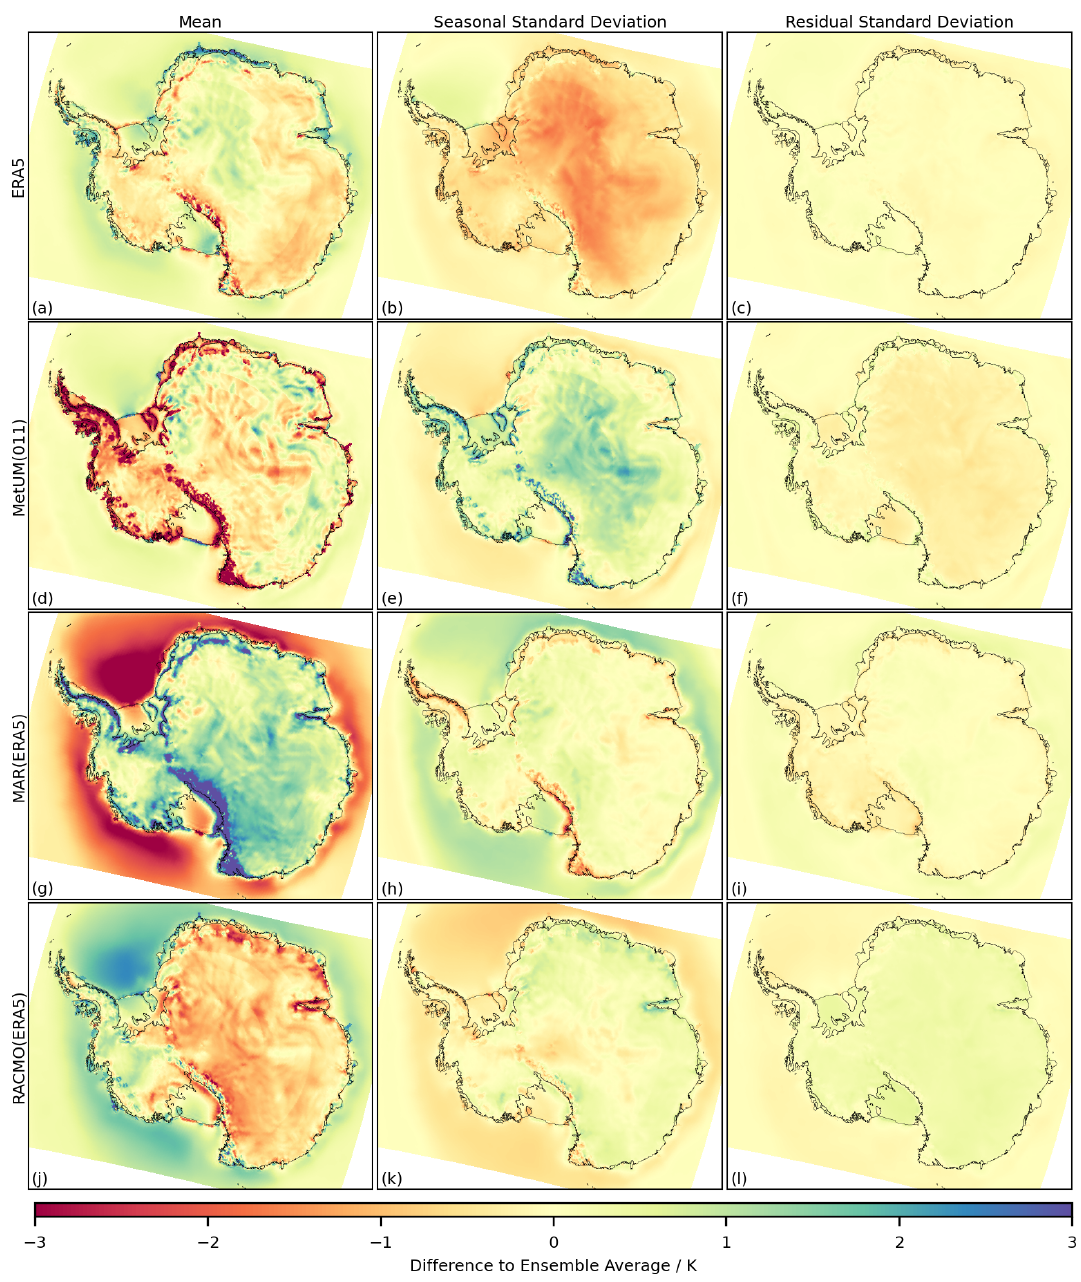
Figure 5. The difference to the ensemble average (model-ensemble avg) for the 1981–2018 time series of near-surface air temperature, in the mean (a, d, g, j) , the standard deviation of the seasonal component (b, e, h, k) and the standard deviation of the residual component (c, f, i, l) . The ensemble includes ERA5 (a–c) , MetUM(011) (d–f) , MAR(ERA5) (g–i) and RACMO(ERA5) (j–l)